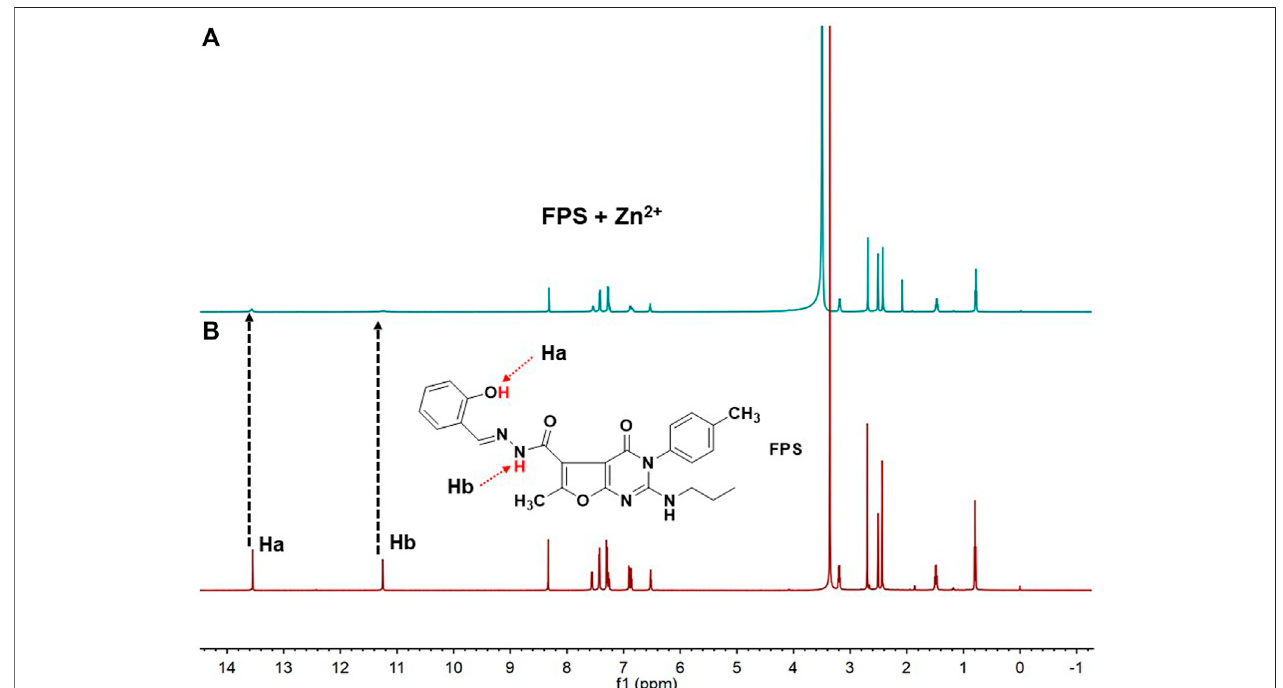
FIGURE 6 | 1 H NMR spectra (400 MHz, DMSO- d6 , 298 K) of (A) FPS (6 mm) + Zn 2+ (6 mm) (B) free FPS (6 mm). This indicated that phenolic hydroxyl and amide play important roles of FPS-Zn 2+ complex.